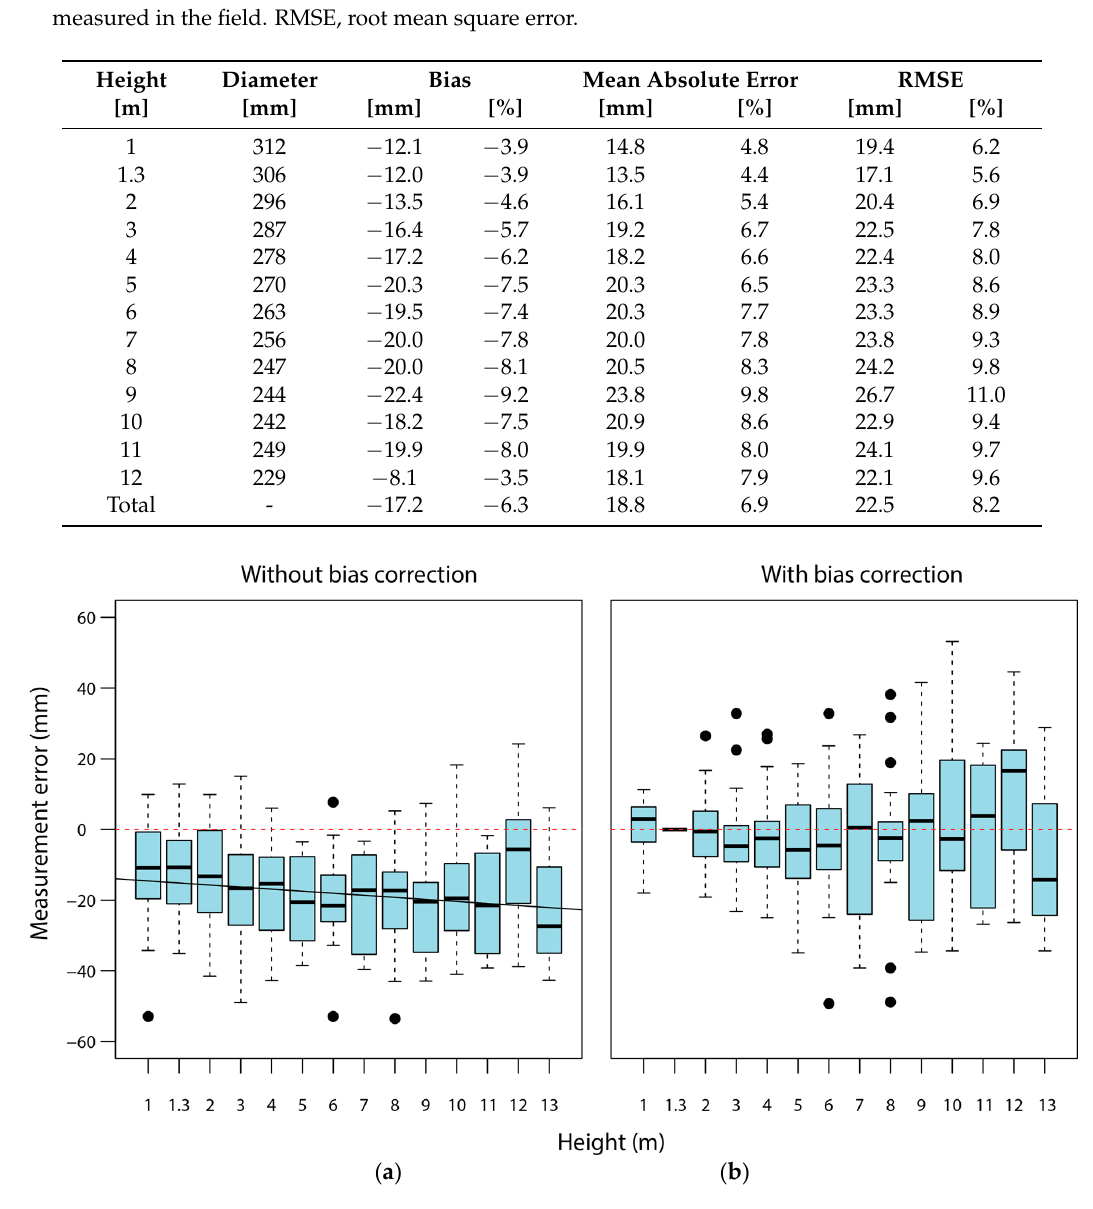
Figure 6. The PPC-based error vs. the stem height; ( a ) uncorrected ( b ) after bias correction with Equation (7). The dots represents outliers, which are estimated using the interquartile range approach. The Kolmogorov–Smirnov test supports the normal distribution of the difference between ground and PPC-based diameters ( p > 0.1), except for the heights of 5 m and 6 m ( p = 0.02 and 0.04, respectively). Grubbs’ test revealed no outliers in the data ( p > 0.05), which justifies a t -test for assessing bias significance at all heights, except 5 m and 6 m. The t -test provided strong evidence ( p < 0.01) that both bias and MAB are significantly different from 0, when applicable. For 5 m and 6 m, at which the t -test was not appropriate, the Wilcoxon test confirms the presence of significant